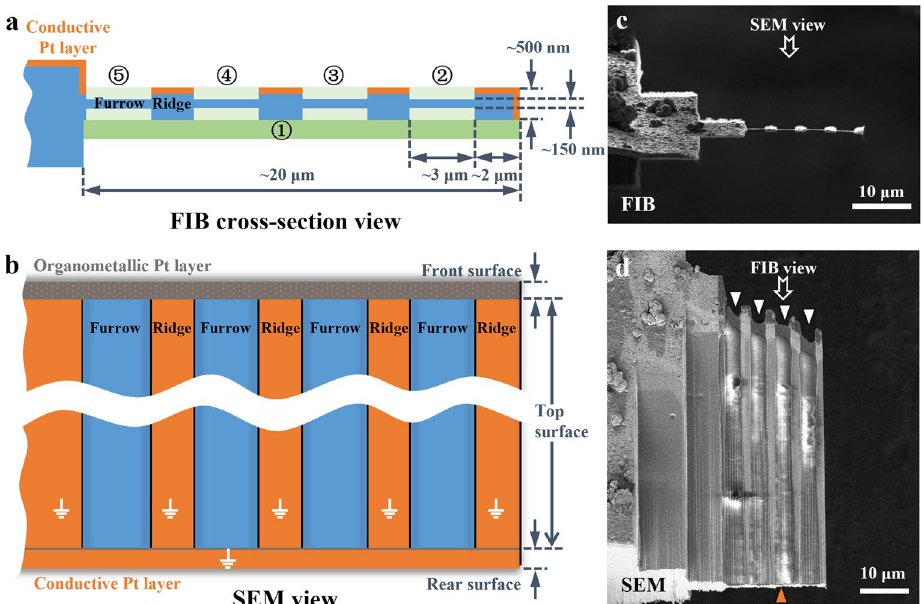
Figure 4. Fine milling procedure and furrow–ridge structure. ( a and b ) Schematic diagrams of the fine milling procedure under FIB cross-section view ( a ) and SEM view ( b ). The green strips (dark green and light green) represent the volumes removed in the sequence indicated by the numbers in circles. The orange edges and surfaces indicate the conductive Pt layer. The gray surface is the organometallic Pt layer coated by a gas injection system (GIS). The orange dots on the front surface indicate the conductive Pt layer which might be damaged during fine milling. The front, top, and rear surfaces are defined in Supplementary Fig. 6. The blue volumes and surfaces are the remaining materials. ( c ) and ( d ) Finished lamella of a liver sample created by fine milling under FIB view ( c ) and SEM view ( d ), as presented in ( a ) and ( b ), respectively. The FIB and SEM images in ( c and d ) were acquired using Helios (FEI